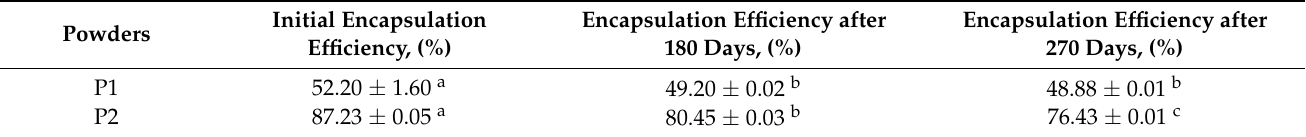
Table 4. Initial encapsulation efficiency of the powders obtained by the microencapsulation of the sea buckthorn extracts and its stability during 270 days of